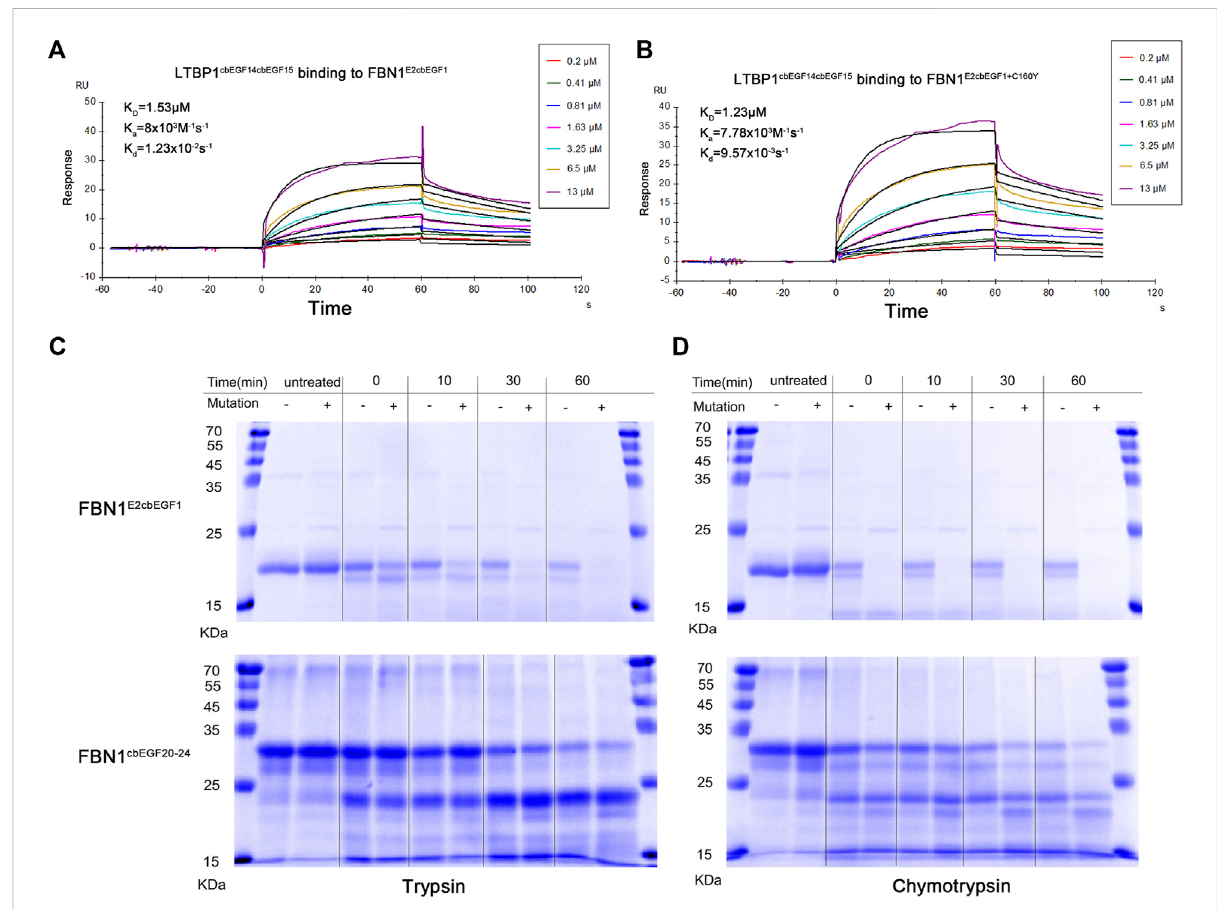
FIGURE 3 Af fi nity and Proteolytic degradation of the wild-type and mutant recombinant fi brillin-1 polypeptides. Af fi nity analysis of wild-type fi brillin-1 polypeptides (FBN1 E2cbEGF1 ) (A) or mutant recombinant fi brillin-1 polypeptides (FBN1 E2cbEGF1+C160Y ) (B) and LTBP1 polypeptides (LTBP1 cbEGF14cbEGF15 ). Wild-type (-) or mutant (+) recombinant FBN1 E2cbEGF1 polypeptides (C) and FBN1 cbEGF20-24 polypeptides (D) were incubated with trypsin (left) or chymotrypsin (right) for untreated, 0, 10, 30, and 60 min, and analyzed using SDS gel electrophoresis and Coomassie brilliant blue staining. Reduced marker proteins are indicated on the left in